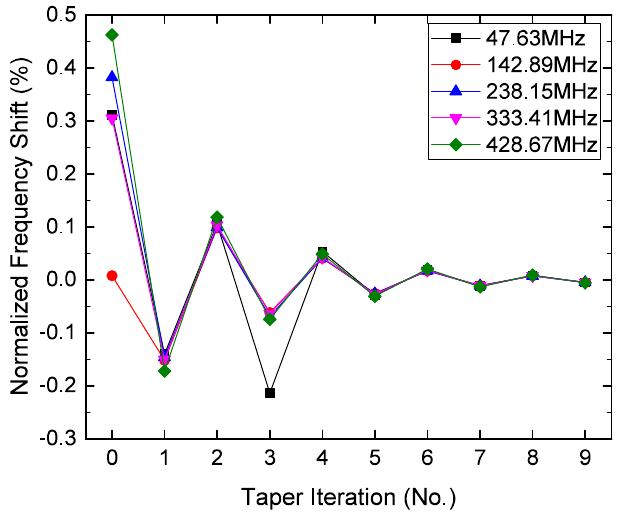
FIG. 10. Frequency convergence with taper simulation iteration